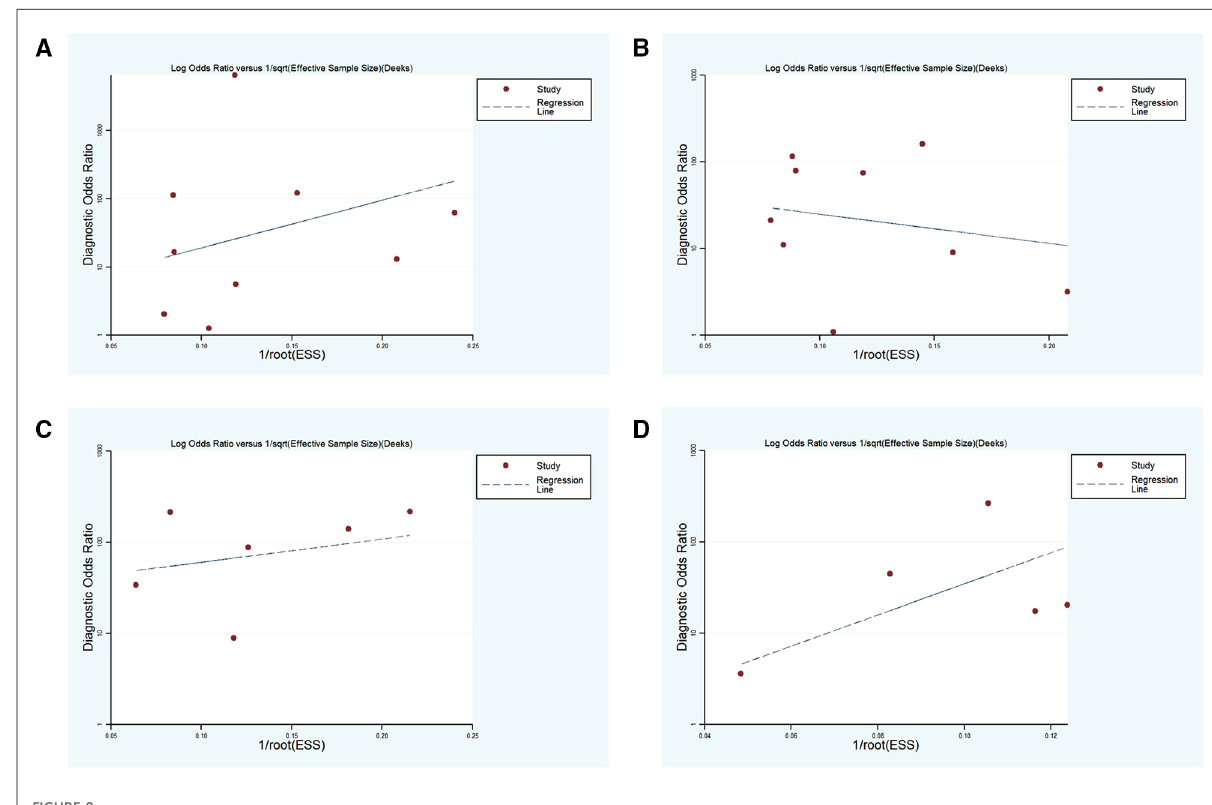
FIGURE 8 ( A – D ) funnel plots of subgroup 1 – 4,